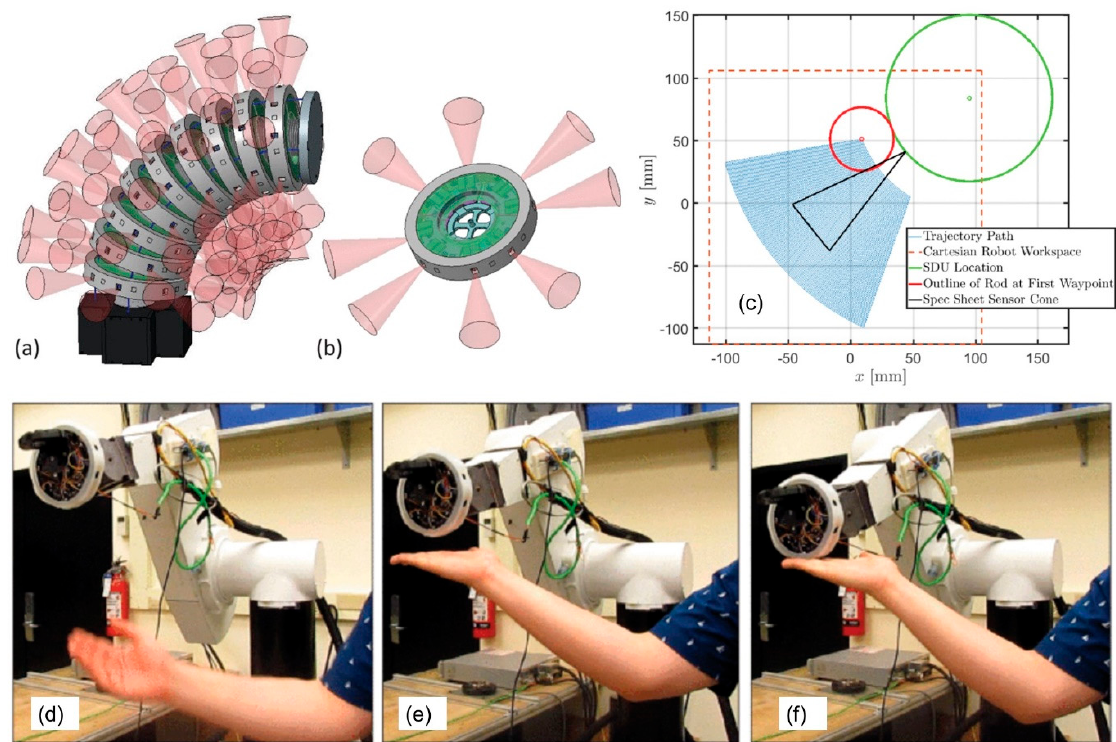
Figure 19. ( a ) Continuum segment augmented with proximity sensing, mapping, force sensing and localized contact detection capabilities. ( b ) Multi-modal sensing disk unit (SDU). ( c ) Trajectory of the Cartesian stage robot during the sensor characterization experiment. Video snapshots showing ( d ) robot moving with constant velocity, ( e ) slowing down near human contact and ( f ) stopping motion after detecting contact. Reprinted/adapted with permission from Ref. [198]. Copyright 2014, IEEE.